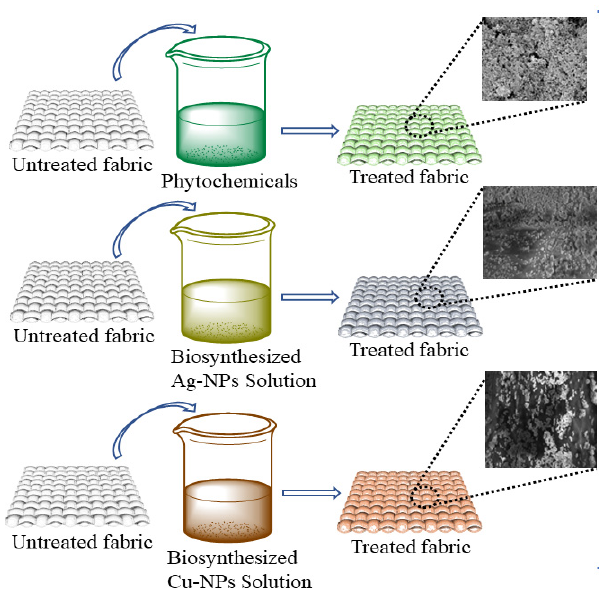
Figure 4. Scheme representing the coating of different types of antimicrobic agents used for the fabrication of the textile. Table 1. Design of experiments for the developed samples.